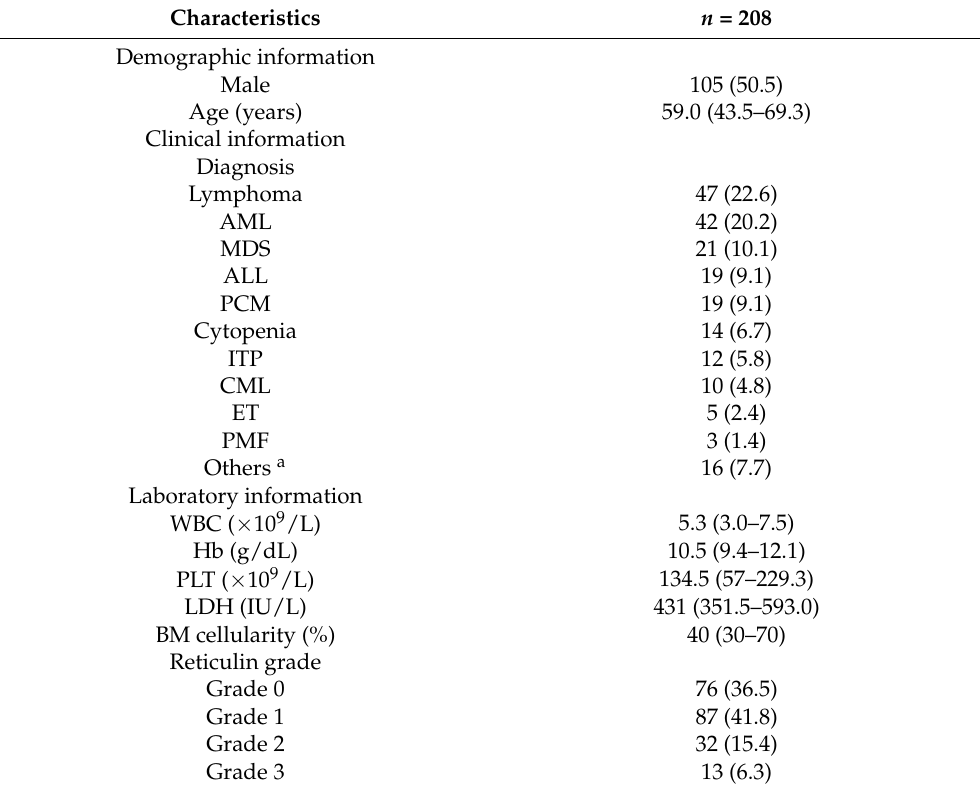
Table 1. Characteristics of the study